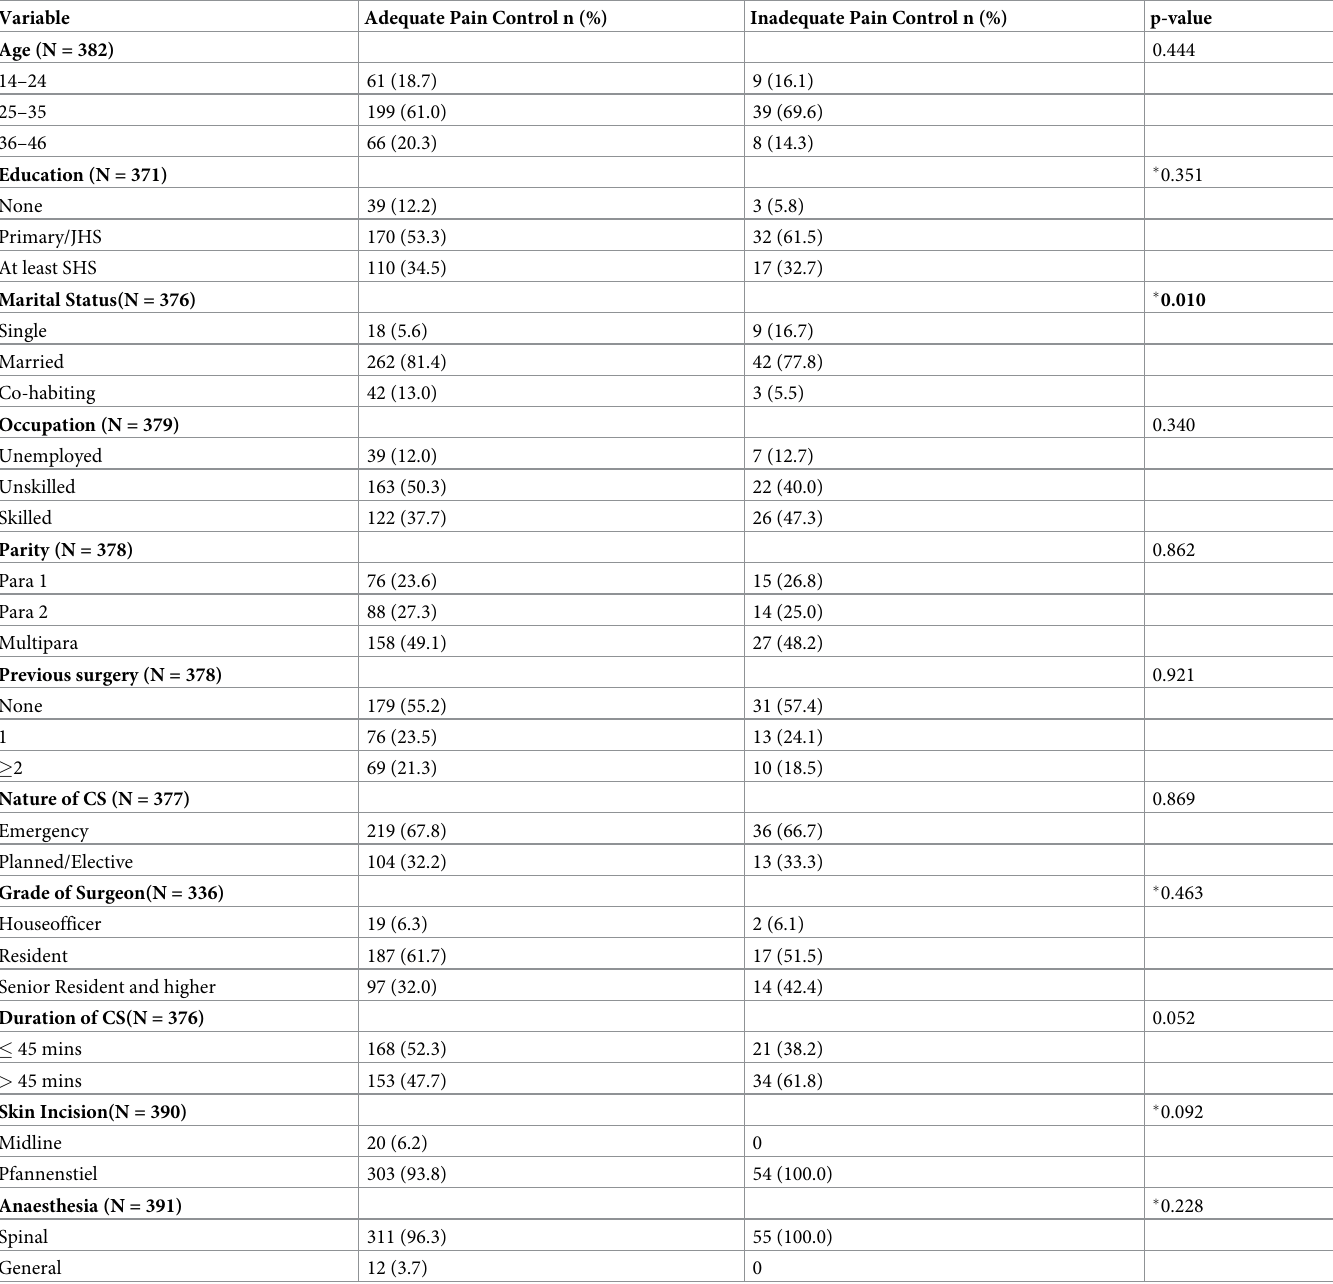
Table 5. Association between participant demographic and clinical characteristics and adequacy of pain control at 24–36 hours